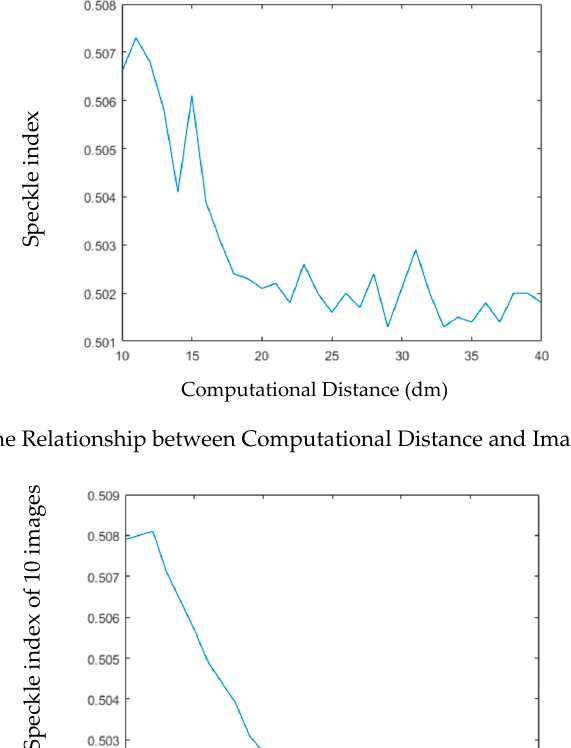
Figure 13. The Relationship between Computational Distance and Imaging Quality.